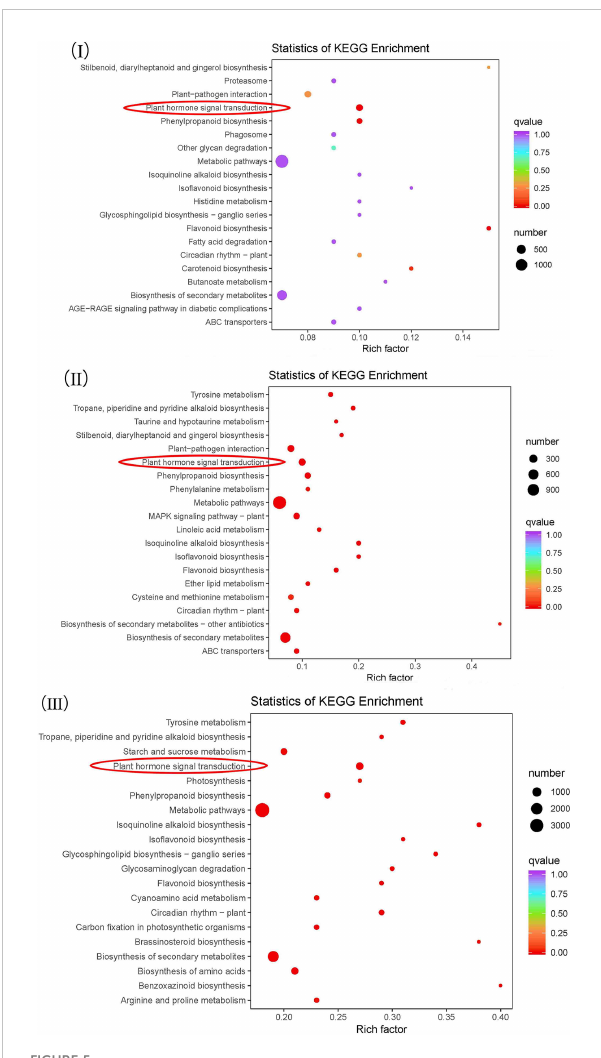
FIGURE 5 KEGG enrichment analysis of the differential genes. I-III represent KEGG enrichment of differential genes at NEC vs. EC, EC vs. GE and GE vs. CE,